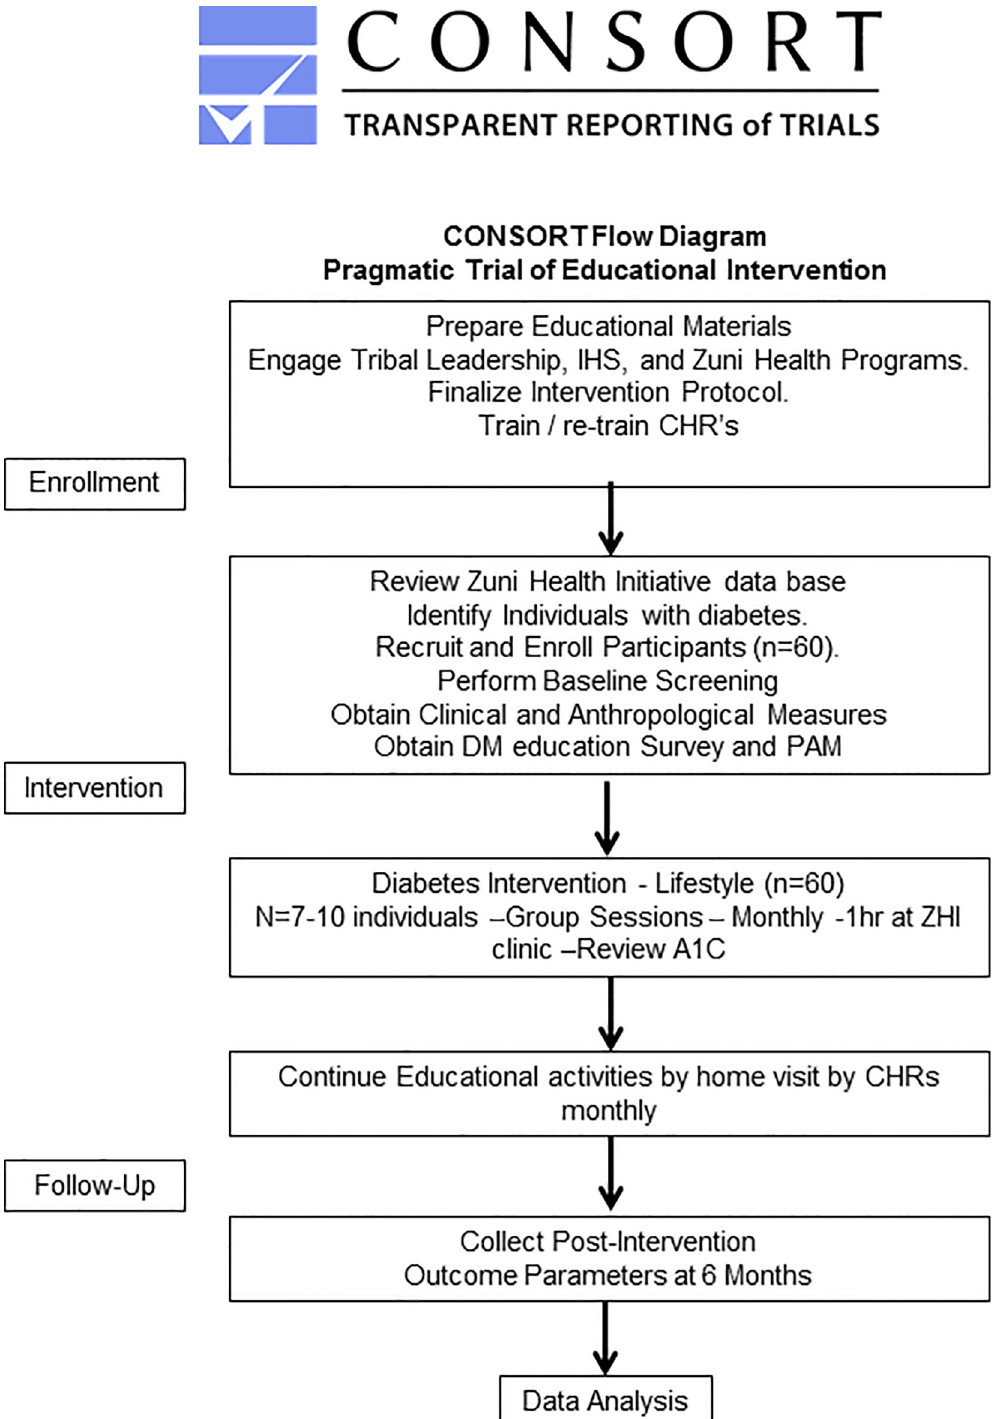
Fig 1. Pragmatic trial of educational intervention — CONSORT Participant Flow Chart – Study Design.